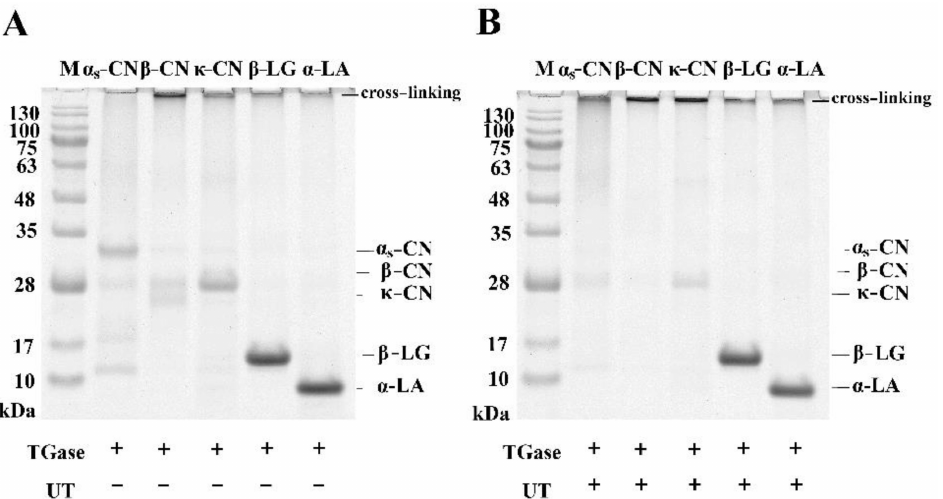
Figure 2. SDS-PAGE image showing individual α s -CN, β -CN, κ -CN, α -LA and β -LG treated with TGase (6.0 units/mL) and UT at 30 ◦ C for 60 min. ( A ) TGase, ( B ) with TGase and UT. M = protein marker. The experiments on the sample were performed in